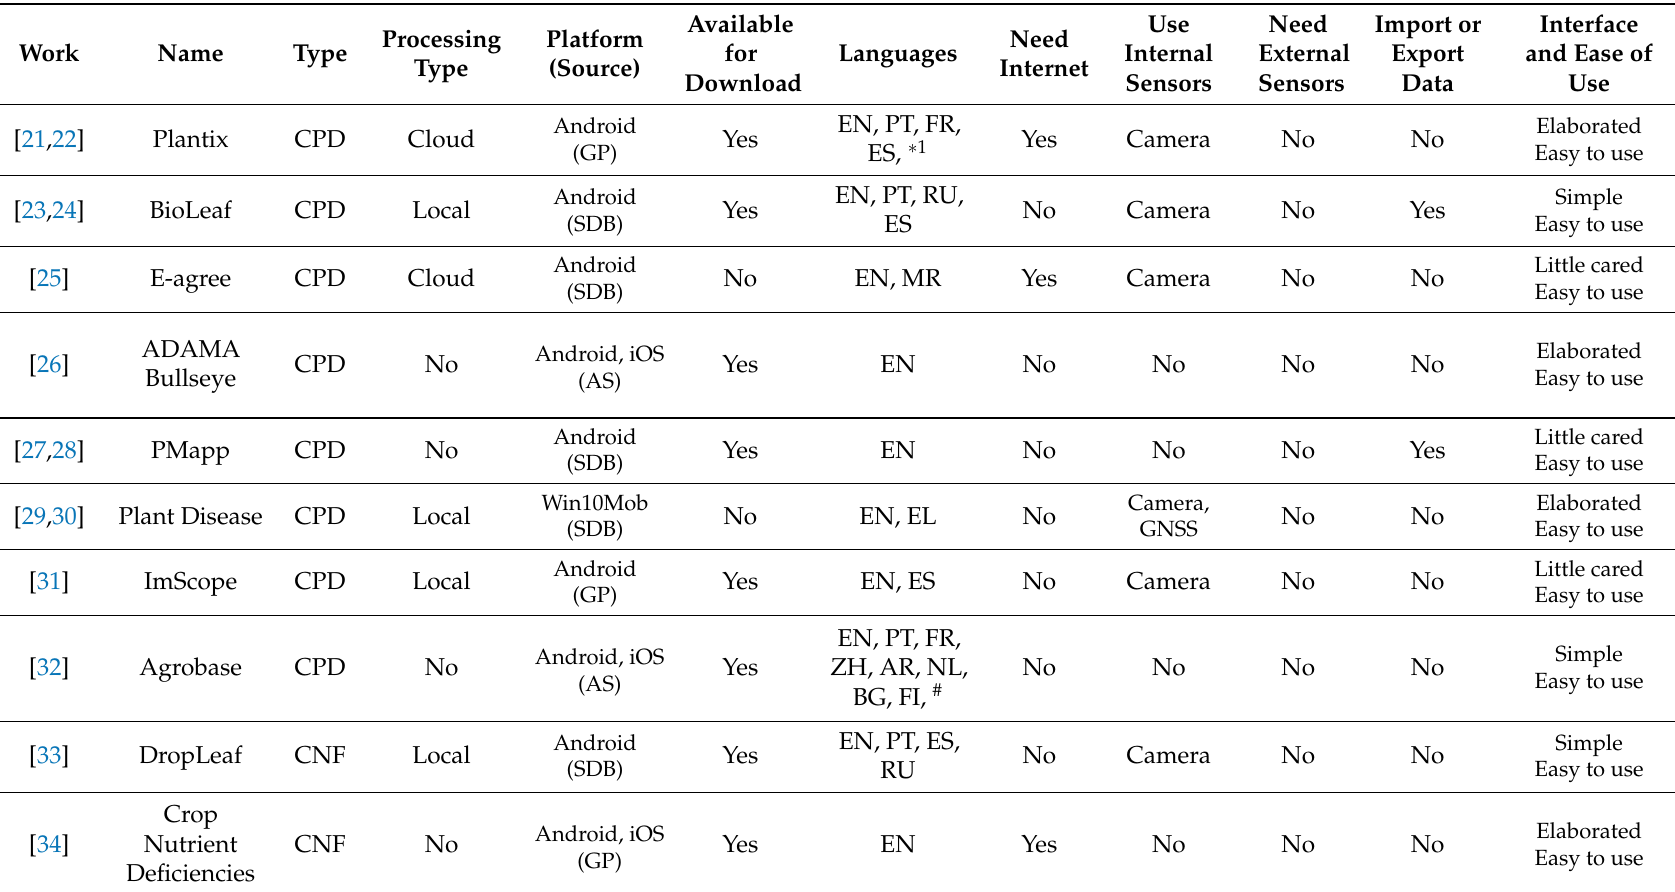
Table 3. Comparison of the applications presented in this